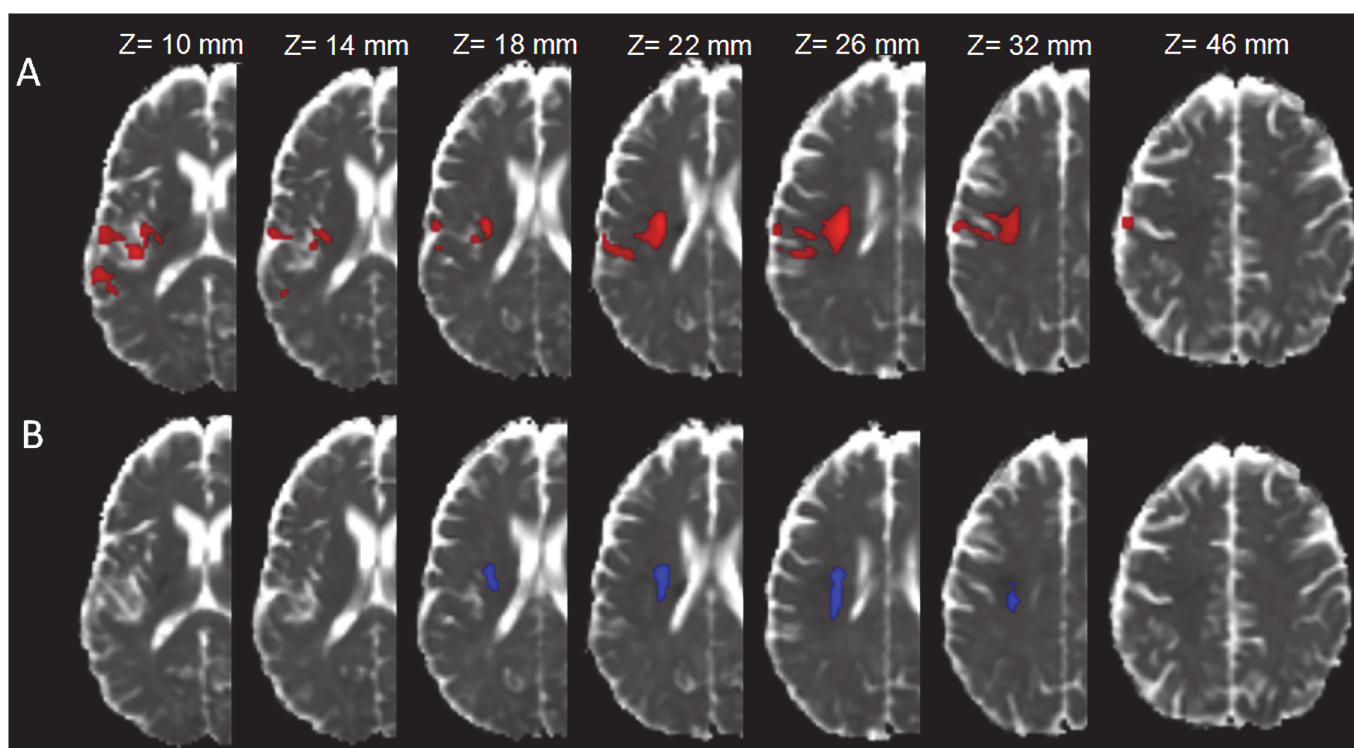
Fig 2. Region with lower ADC values at day one in non-recanalized patients and in poor outcome patients. A. Superposition of the area of day-one ADC decrease associated with 90-day poor outcome (in red) on ADC images (MNI space, z-coordinates). B. Superposition of the area of day-one ADC decrease associated with non-recanalized (vs. recanalized) patients (in blue) on ADC images (MNI space, z-coordinates). Images are shown using neuroradiological conventions (right hemisphere on the left side).